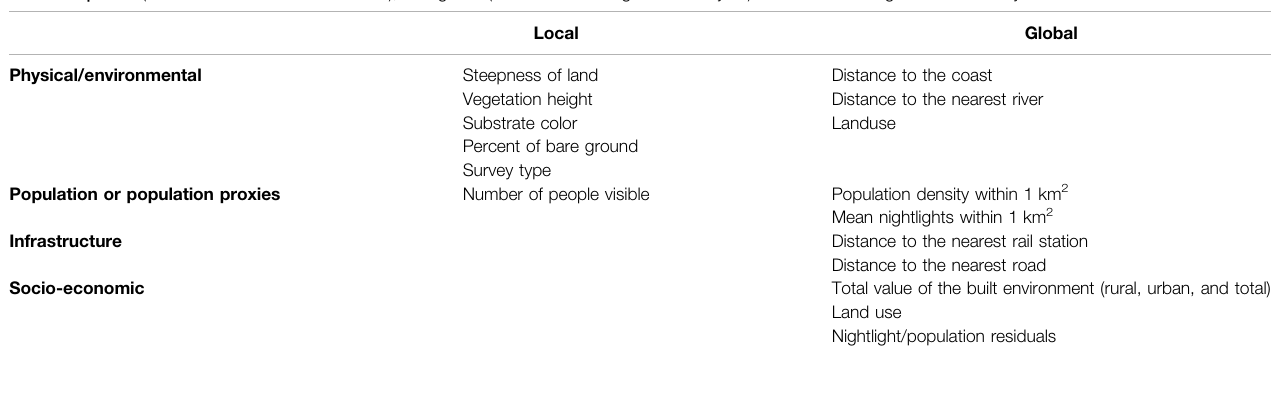
TABLE 1 | Local (recorded at site or transect level), and global (determined from global GIS layers) covariates investigated in the